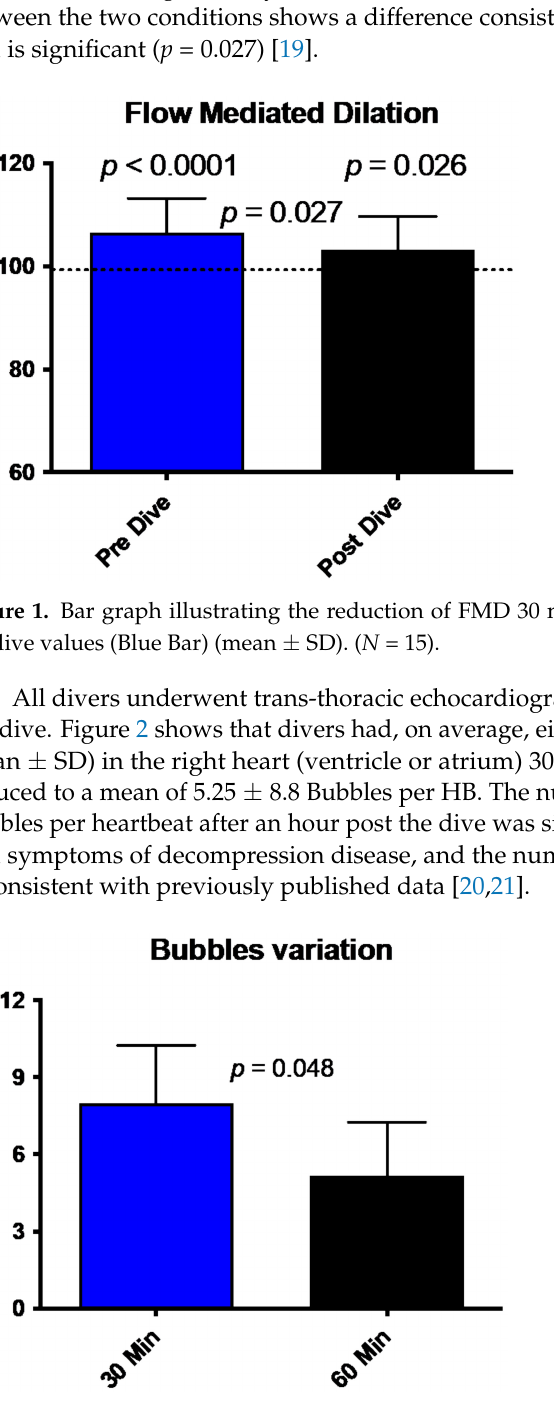
Figure 2. Number of bubbles (BBS = Bubbles) per heartbeat 30 min (blue bar) and 60 min (black bar) after diving. (Mean ±